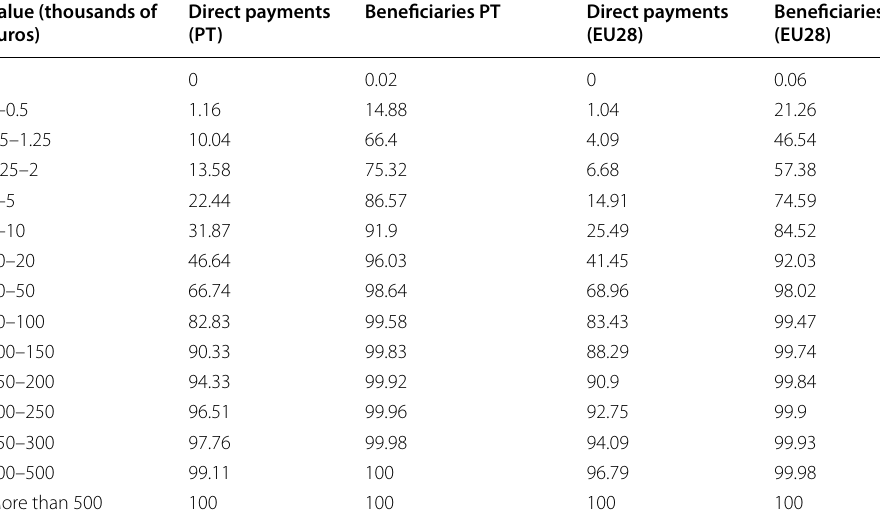
Source : DGAGRI, European Commission